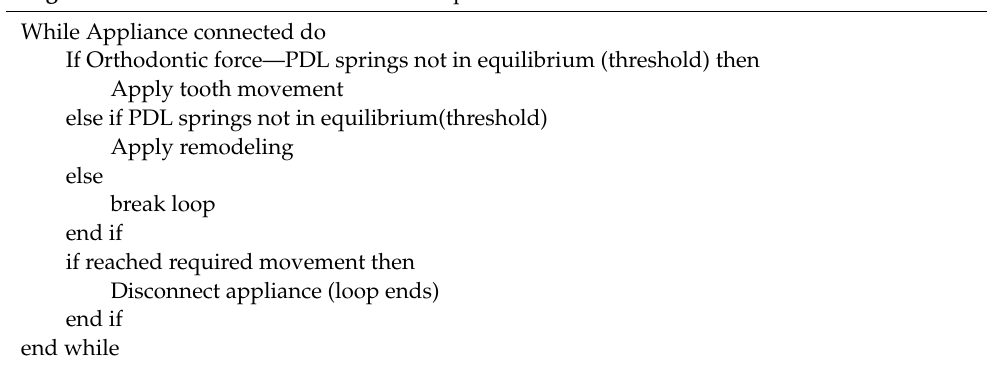
Algorithm 1: Tooth orthodontic movement